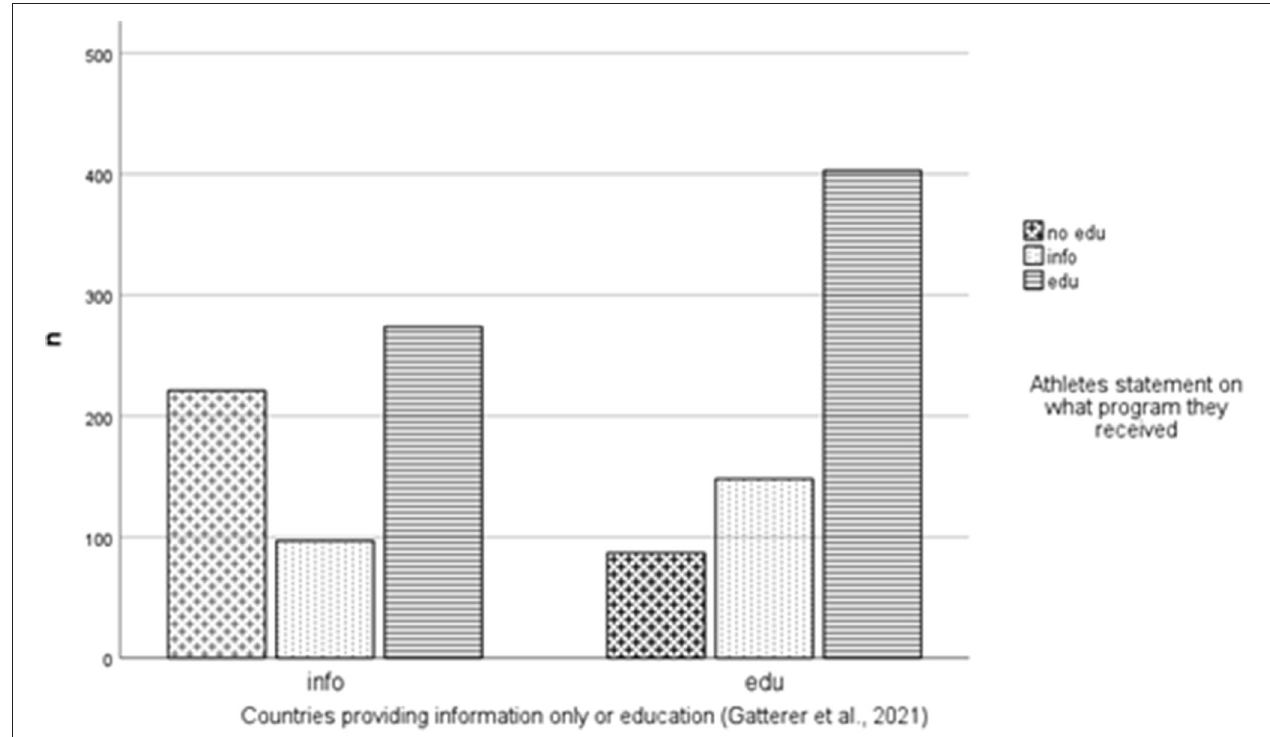
FIGURE 5 | Distribution of perceived education of athletes from countries providing either information or education. Chi square 91.90, p < 0.001, Phi =